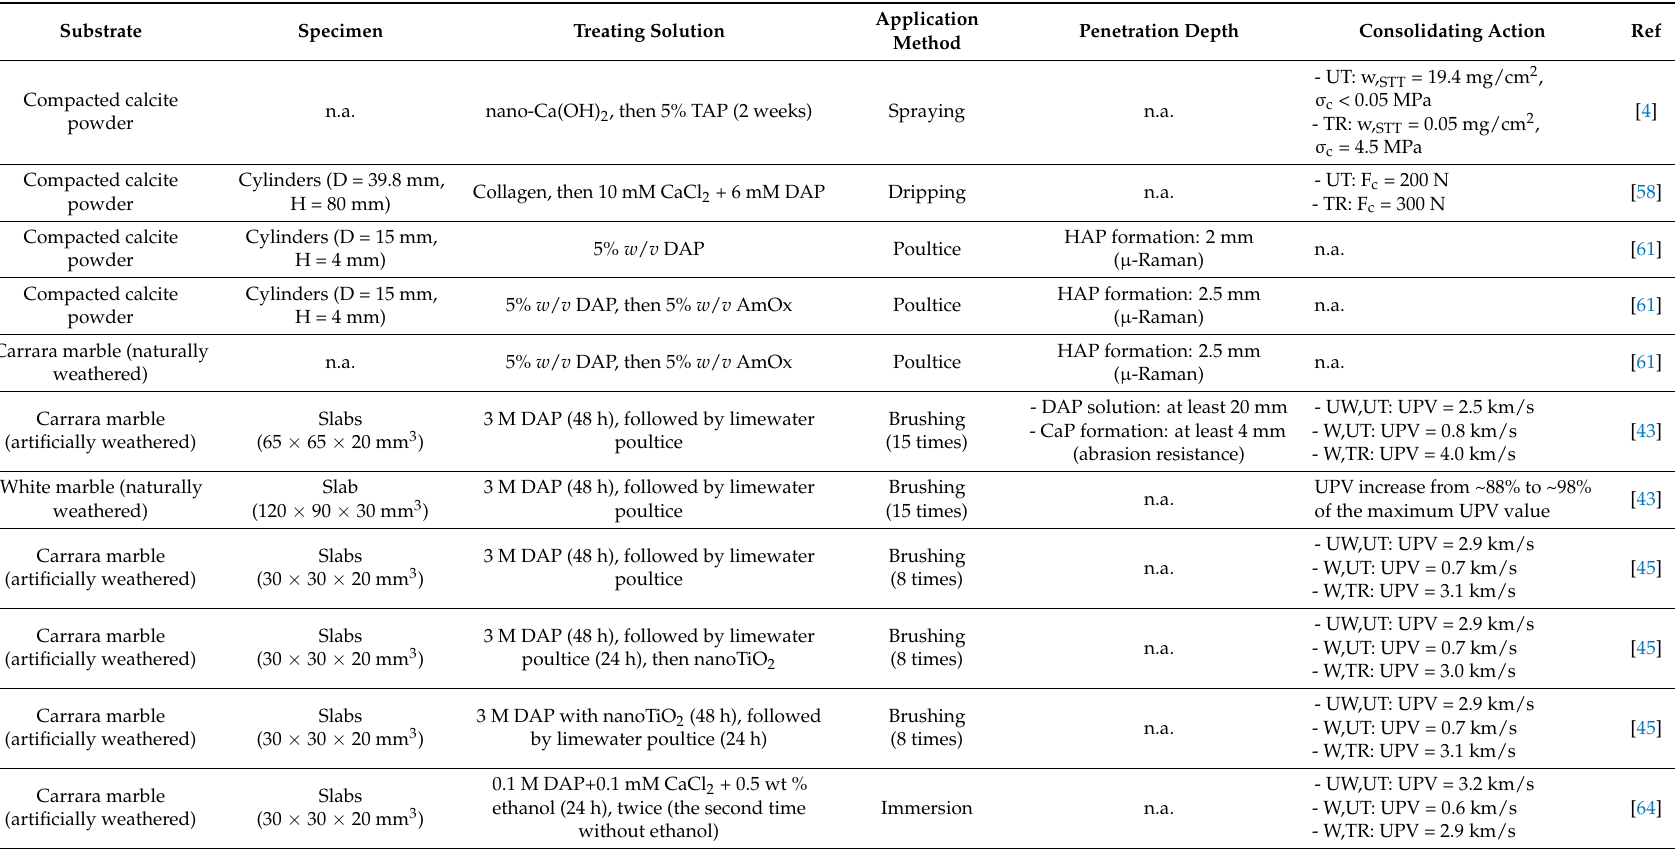
Table 4. Consolidating ability of the phosphate treatment applied to marble (n.a. = not available; D = diameter; H = height; UW = unweathered; W = weathered; UT = untreated; TR = treated; w, STT = weight loss after scotch tape test; σ c = compressive strength; F c = compression force for a given cross section; UPV = ultrasonic pulse velocity; E d = dynamic elastic modulus; * multiple values are reported for samples preliminarily decayed to two different levels; ** multiple values are reported for two different directions, parallel and perpendicular to marble